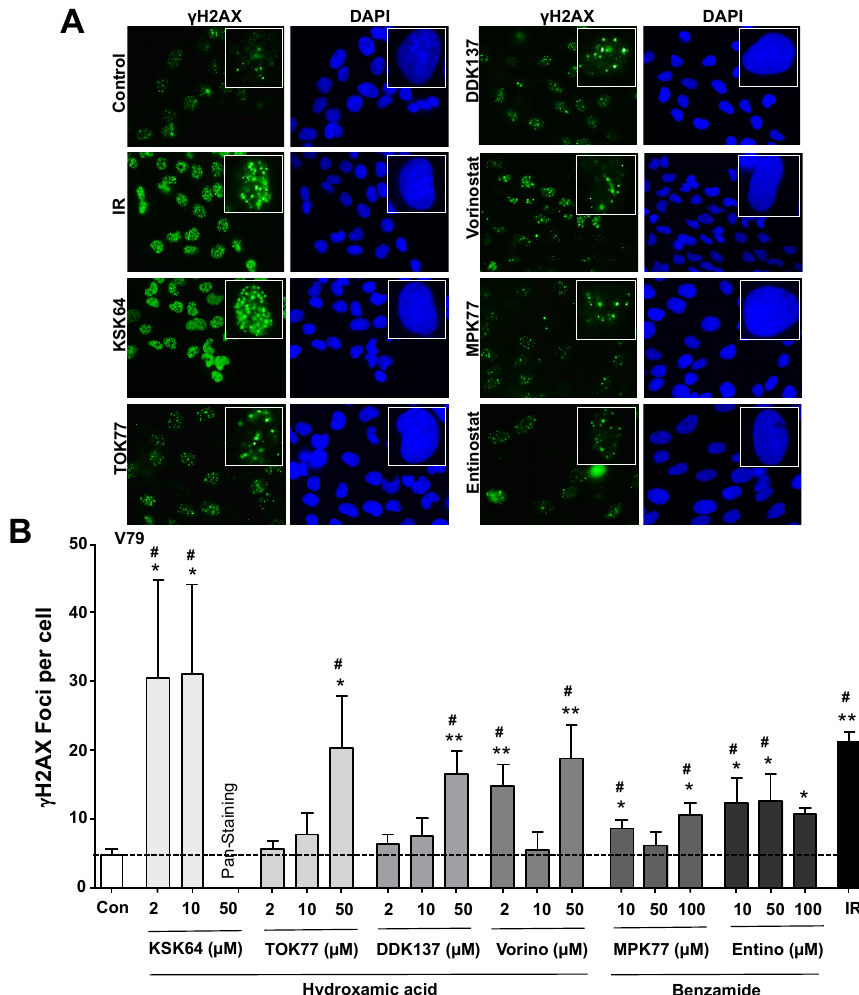
Figure 3. Hydroxamic acid- and benzamide-type HDACi stimulate the formation of nuclear γ H2AX foci. The formation of nuclear γ H2AX (Ser139 phosphorylated histone H2AX) foci was analyzed 24 h after the treatment of non-malignant V79 cells with representative HDACi candidate compounds. Ionizing radiation (IR) (radiation dose: 4 Gray (Gy)) was used as positive control and cells were analyzed 30 min after irradiation. (A) Representative pictures obtained following treatment with the hydroxamic acid-type HDACi KSK64, TOK77, DDK137, vorinostat (each 10 µ M) or the benzamide-type HDACi MPK77 and entinostat (50 µ M). (B) The number of nuclear γ H2AX foci per cell is shown as the mean ± SEM from three independent experiments (n = 3). In each experiment 50 nuclei were evaluated; *, p ≤ 0.05; **, p ≤ 0.01 as compared to untreated control (Student’s t -test); # ≤ 0.05 (one-way ANOVA with Dunnett’s post hoc test).